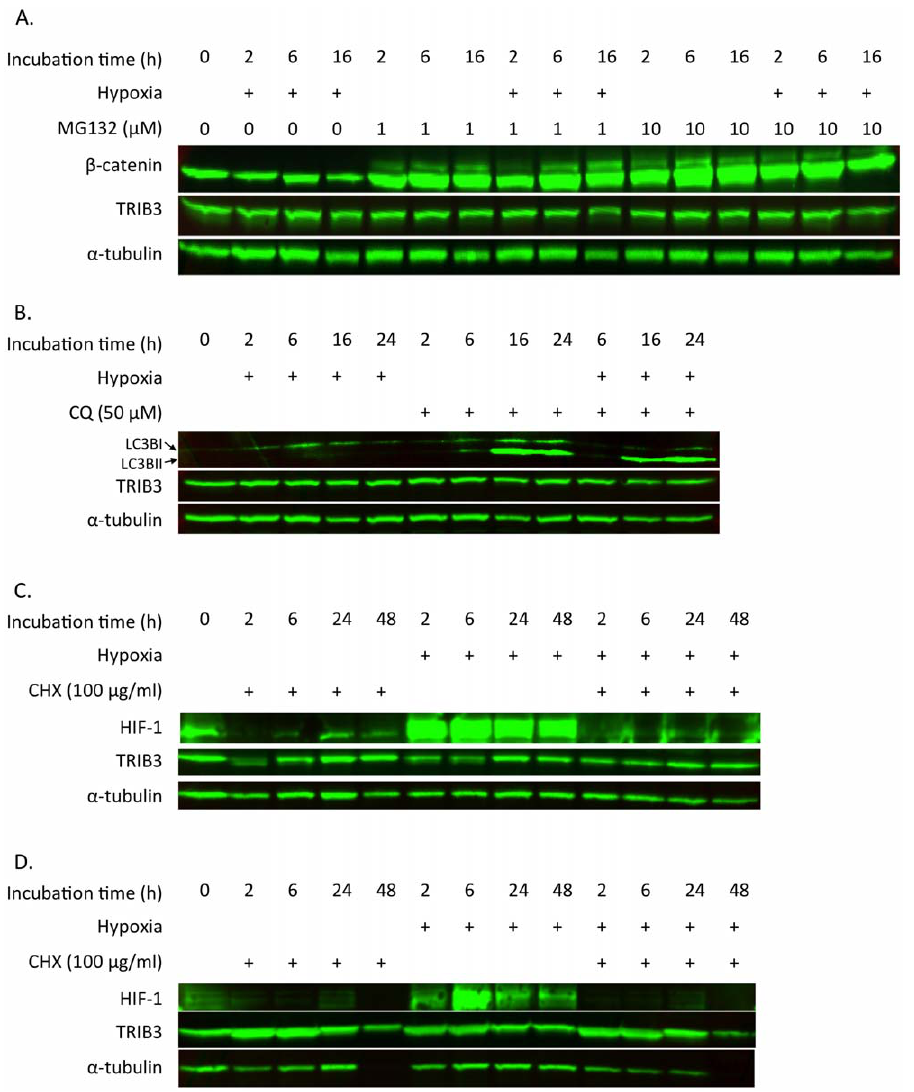
Figure 2. Effect of proteasome inhibition on TRIB3 protein levels. A. Western blot of MDA-MB-231 cells treated with MG132 and exposed to hypoxia (0.1% oxygen) immunostained for b -catenin (positive MG132 control), TRIB3 and a -tubulin (loading control). B. MDA-MB-231 cells treated with hydroxychloroquine (CQ) and exposed to hypoxia (1% oxygen) immunostained for LC3b (positive autophagy inhibition marker), TRIB3 and a - tubulin (loading control). C. MDA-MB-231 cells treated with cycloheximide (CHX) and exposed to hypoxia (1% oxygen) immunostained for HIF-1 (positive translation inhibition control), TRIB3 and a -tubulin (loading control). D. MCF-7 cells treated with cycloheximide (CHX) and exposed to hypoxia (1% oxygen) immunostained for HIF-1 (positive translation inhibition control), TRIB3 and a -tubulin (loading